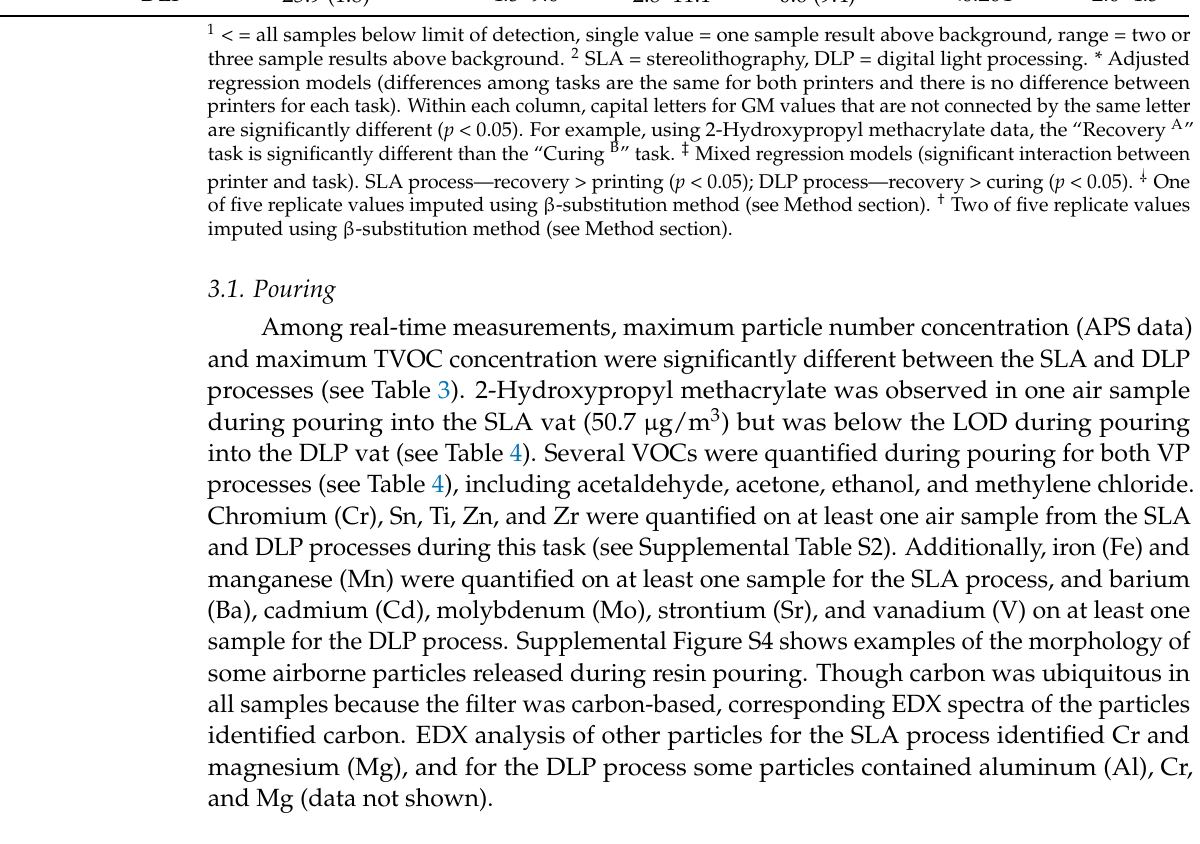
Table 3. Geometric mean (geometric standard deviation) maximum background-corrected particle and total volatile organic compound (TVOC) concentrations by process and task (n = 5